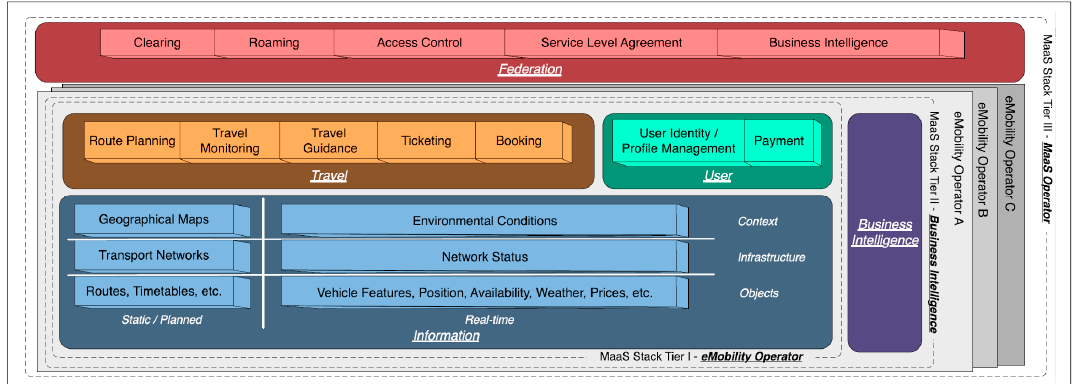
Figure 5. Concept for the architecture of an open platform for modular mobility services by Pflügler et al. Reproduced from Pflügler et al. [22].